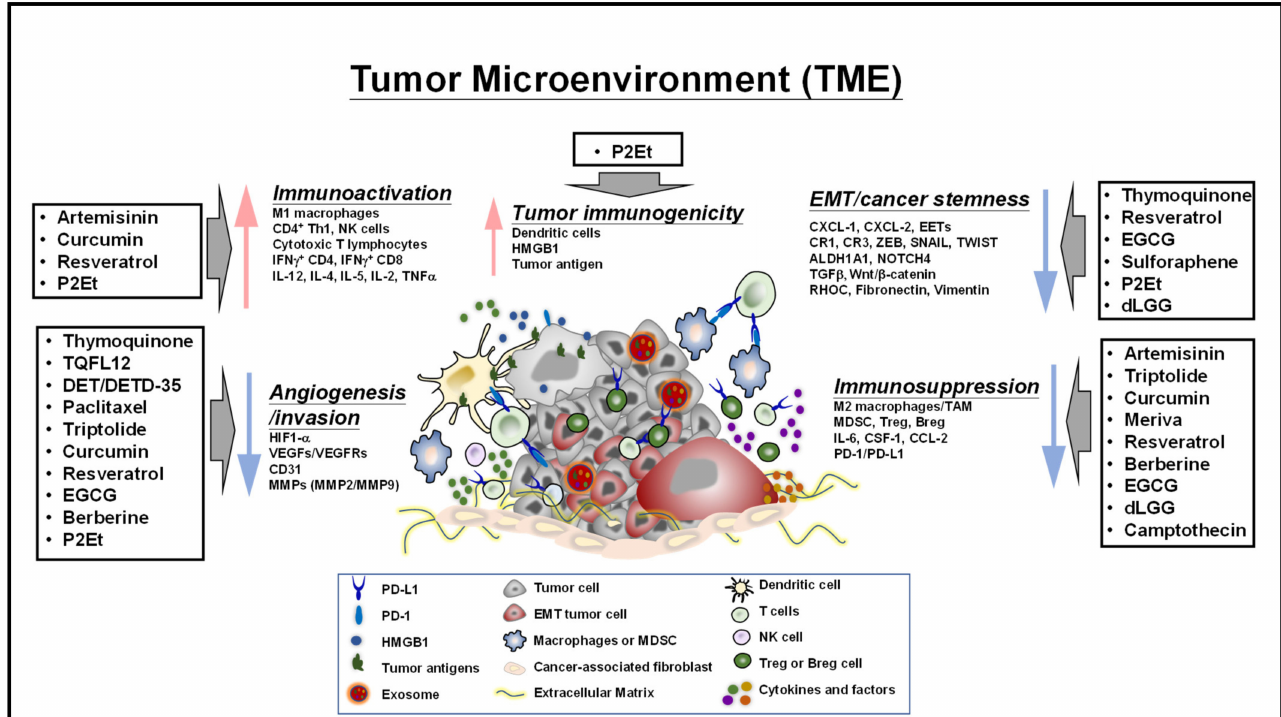
Figure 2. The immunomodulatory effects of phytocompounds in the tumor microenvironment. The tumor microenvi- ronment is composed of heterogeneous tumor cells, cancer-associated fibroblasts, and various immune cells, including antigen-presenting cells-DCs and macrophages, immuno-suppressive cells (TAMs, MDSCs, regulatory T and B lympho- cytes), and effector cells (NK, Th1, and cytotoxic T lymphocytes). TME creates a niche for the mutual interactions between malignant tumor cells and neighboring cells, resulting in cellular and molecular changes and fostering critical events that control the balance between immunosurveillance and immune escape, fine-tunes tumor immunogenicity, and supports EMT, cancer stemness, invasion, metastasis, and angiogenesis. This review provides several exemplar phytocompounds that confer high therapeutic potentials targeting key autocrine/paracrine cytokines, lipid mediators, and/or tumor immune infiltrates involved in antitumor immunities, tumor immunogenicity, and tumor